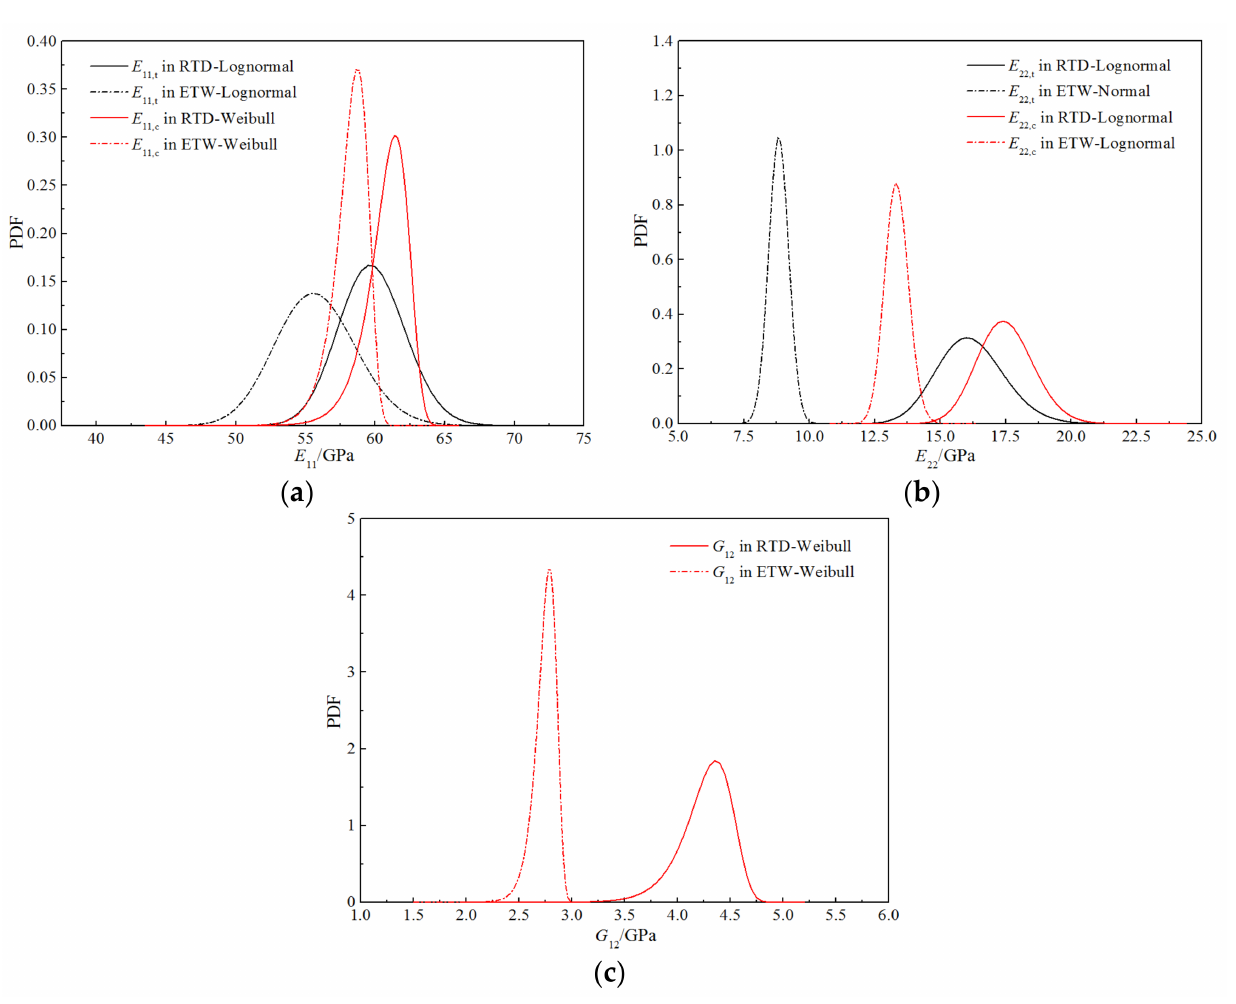
Figure 14. Comparison of the probability curves for the stiffness properties of H-GFRPs. ( a ) E 11 ,